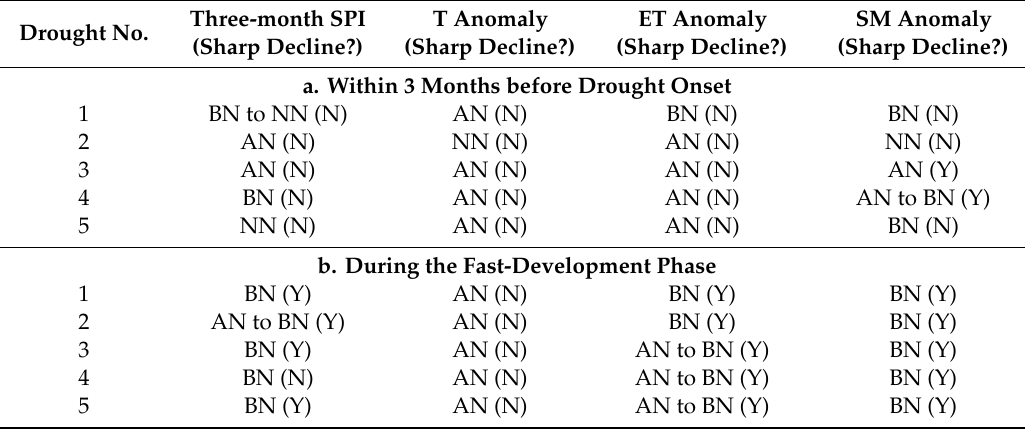
Table 2. Summary of antecedent conditions prior to drought onset and features during the fast-development phase for the five selected flash droughts. Three-month SPI T Drought No. (Sharp Decline?)